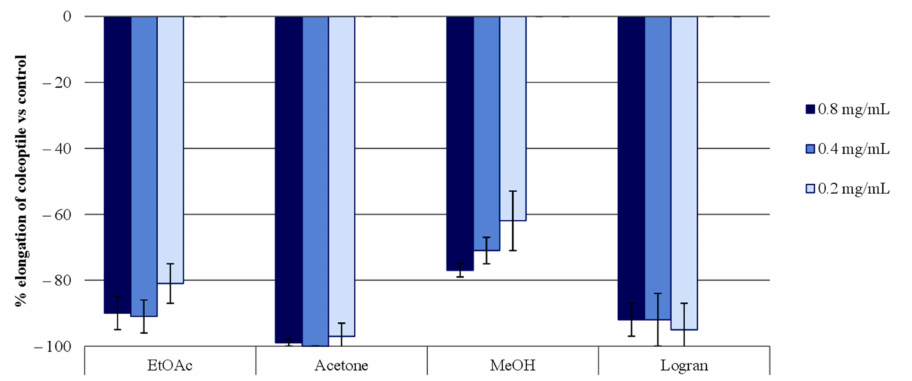
Figure 1. The bioactivities obtained in the etiolated wheat coleoptile bioassay for the Moquiniastrum pulchrum leaf extracts. Values are expressed as the percentage difference with respect to the control. Each bar is the mean ± standard